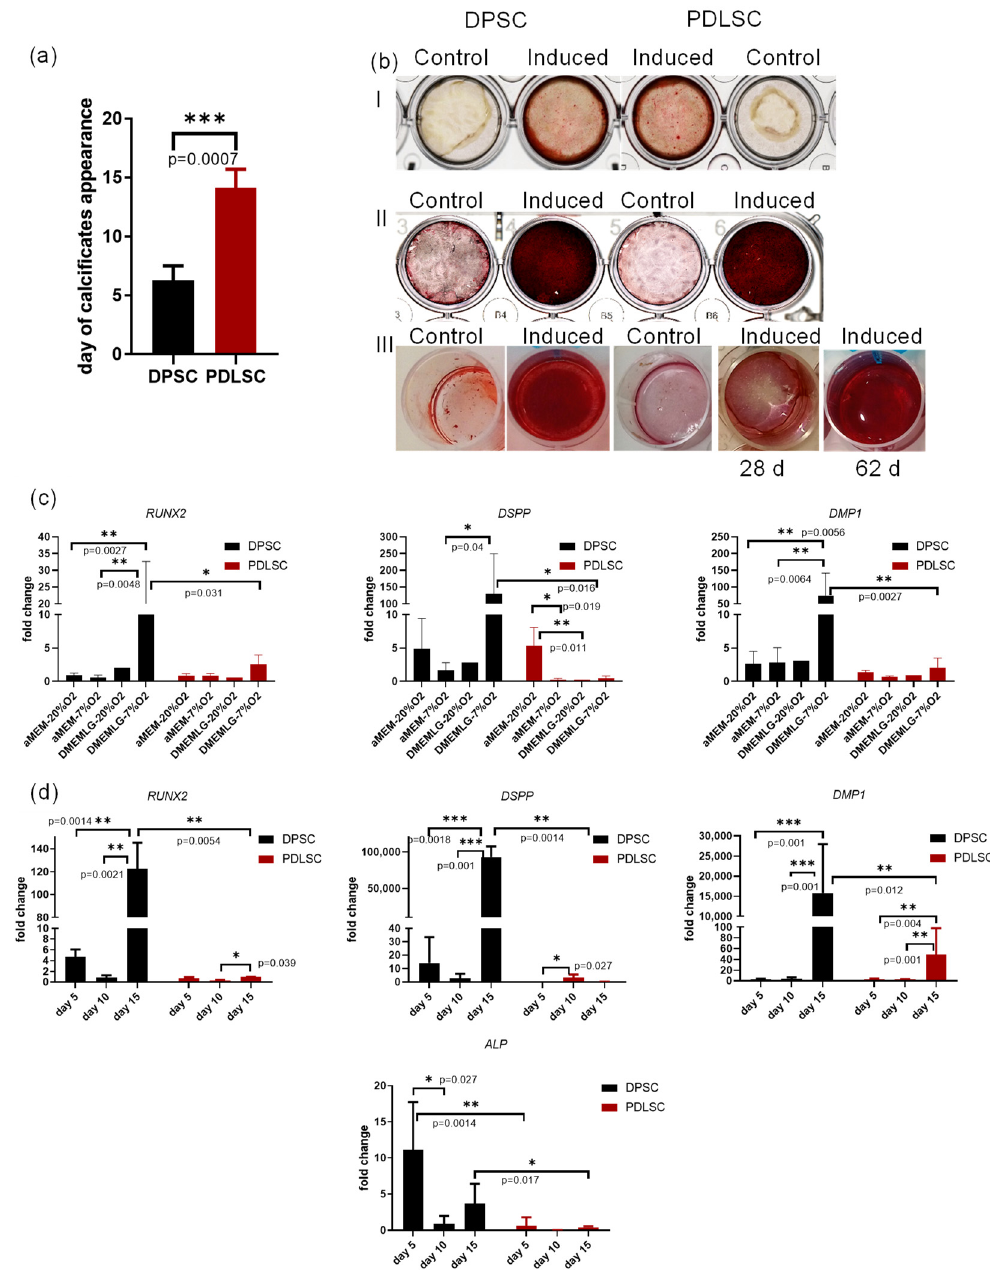
Figure 4. DPSC and PDLSC differentiation after osteogenic induction. ( a ) the rate of appearance of the first visible calcifications, the day when calcifications were revealed is plotted on the Y -axis; ( b ) Alizarin staining of DPSC and PDLSC on days 19 (Panel I) and 28 (Panel II) after osteogenic induction. Panel III: a PDLSC sample with delayed differentiation. ( c ) Transcription of osteogenic and odontogenic markers ( RUNX2 , Dentin sialophosphoprotein DSPP , Dentin matrix acidic phosphoprotein 1 DMP1 ) after 72 h post-induction in different cell culture conditions. Cells were grown in different O 2 concentration (hypoxia (7% O 2 ) and normoxia, 20% O 2 ) and the osteogenic factors were added either in low glucose DMEM or in α -MEM. ( d ) Transcription of osteogenic and odontogenic markers ( RUNX2 , alkaline phosphatase ALP , DSPP , DMP1 ) during 15 days of differentiation in hypoxia. Y -axis—fold change. Reference gene— GAPdH . *— p < 0.05, **— p < 0.01, ***— p < 0.001; the exact p -values are also shown. Thus, both DPSC and PDLSC were capable of osteogenic differentiation. However, DPSC differentiated into the odontoblastic direction.